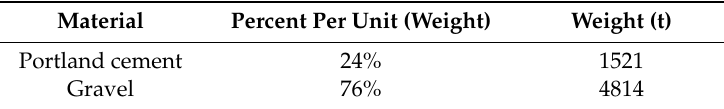
Table 2. Concrete-BOM.